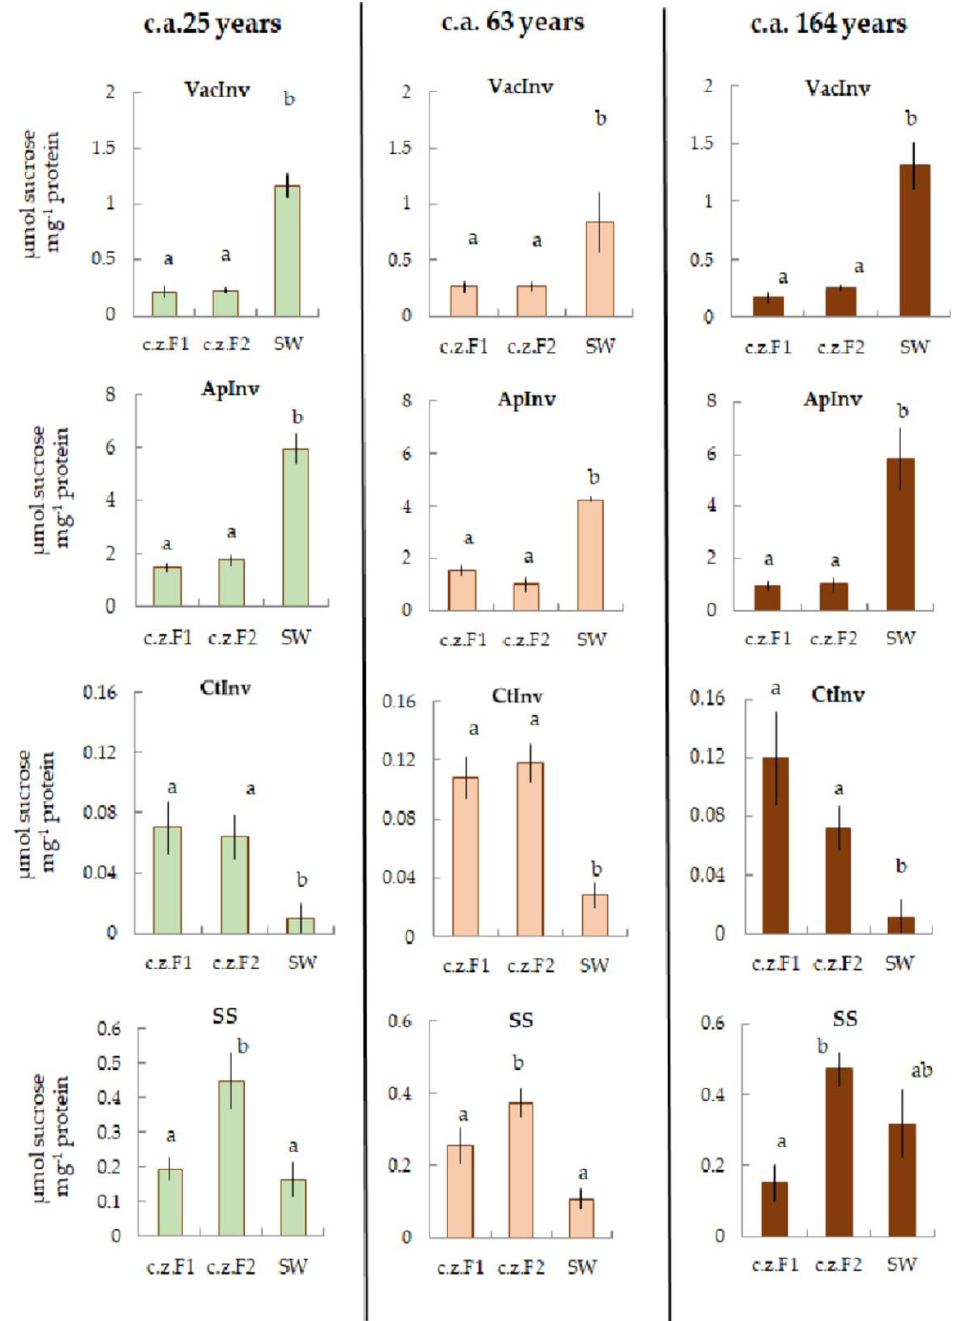
Figure 3. The activities of vacuolar invertase (VacInv) ( µ mol sucrose mg − 1 protein), apoplastic invertase (ApInv) ( µ mol sucrose mg − 1 protein), cytoplasmic invertase (CtInv) ( µ mol sucrose mg − 1 protein), and sucrose synthase (SS) ( µ mol sucrose mg − 1 protein) in F1, F2, and SW of 25, 63, and 164 c.a. years Scots pine trees. Values represent the mean ± SE ( n = 5). The difference was considered significant if p < 0.05. Letters indicate differences between groups F1, F2, and SW.